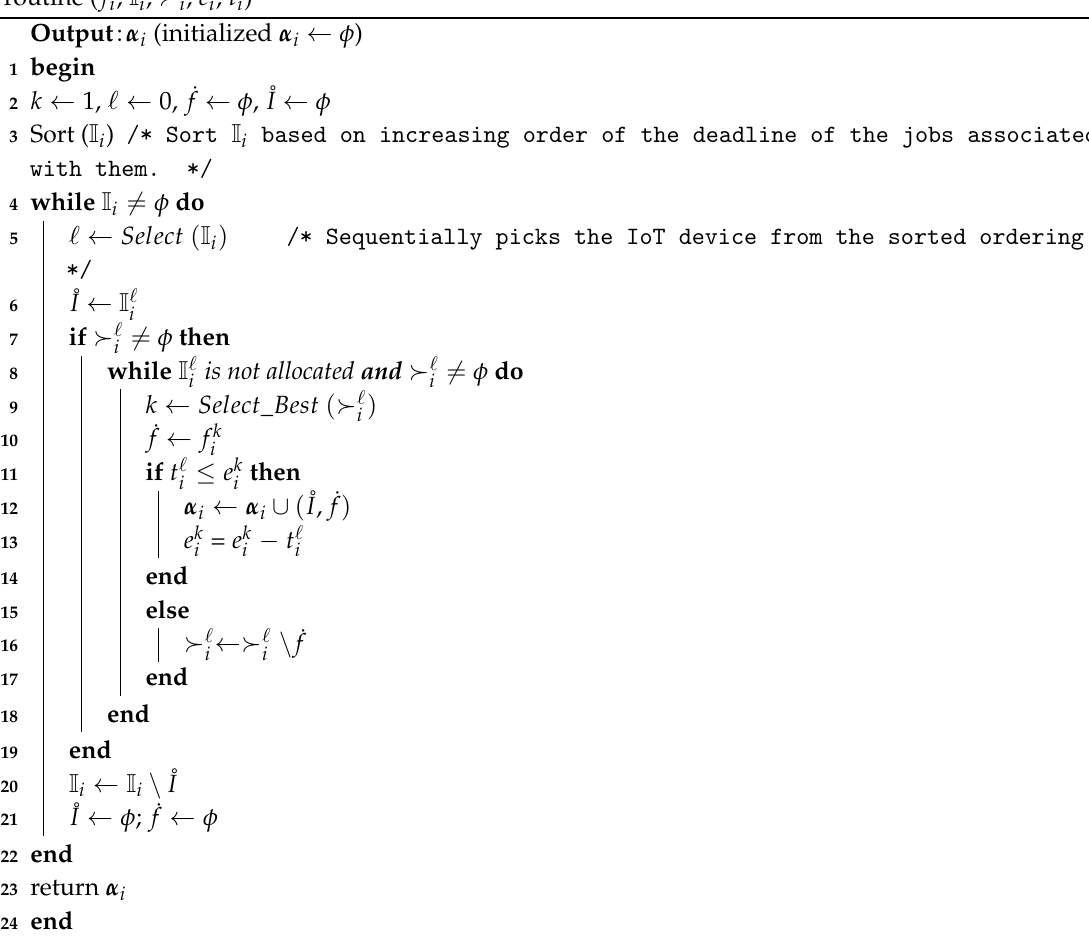
Algorithm 8: Further Modified Truthful Mechanism for Fog Service Allocation